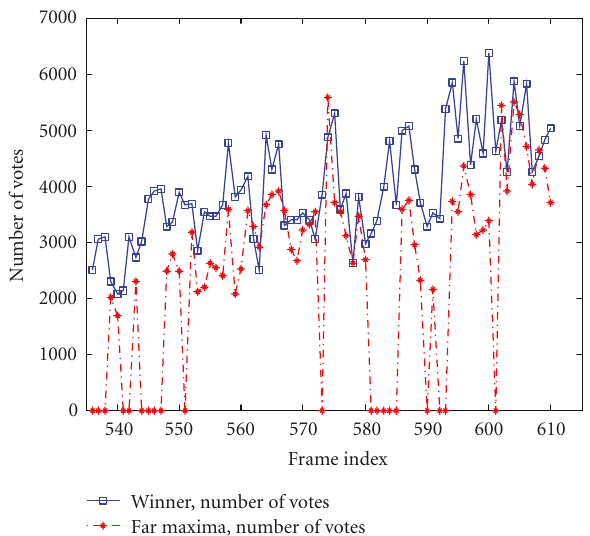
Figure 14: (a) Reference frame (Frame #200), (b) Frame #220, (c) Frame #224, and (d) Frame